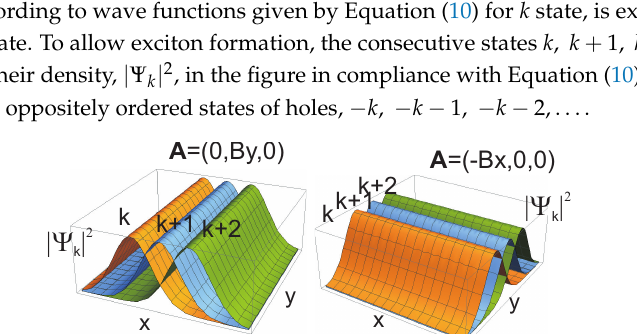
Figure 5. Depending on the gauge of magnetic field B the shape of the electron and hole densities, as given by Equation (10) for the Landau gauge, changes as shown in the figure for two variants of the gauge, A = ( 0, Bx ,0 ) and A = ( − By ,0,0 ) . The striping in the k space is not attributed thus to fixed orientation, due to the gauge